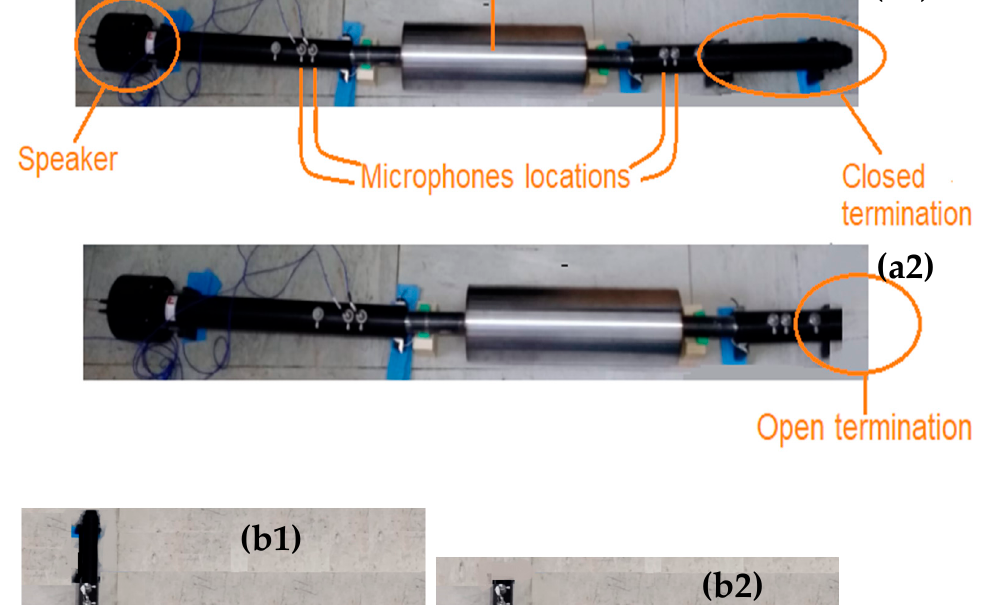
Table 1. Air and water characteristics used in the numerical model.